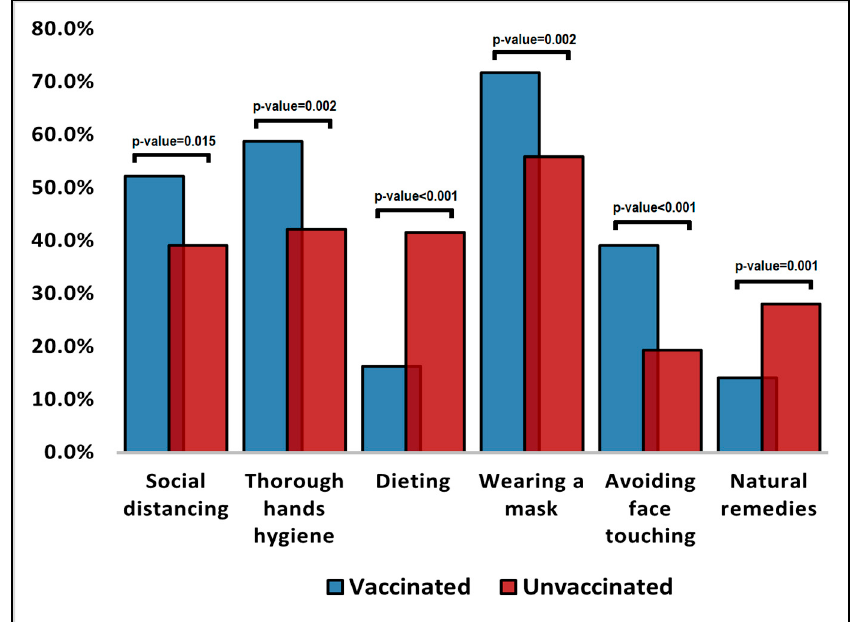
Figure 2. Beliefs over factors that can prevent COVID-19.